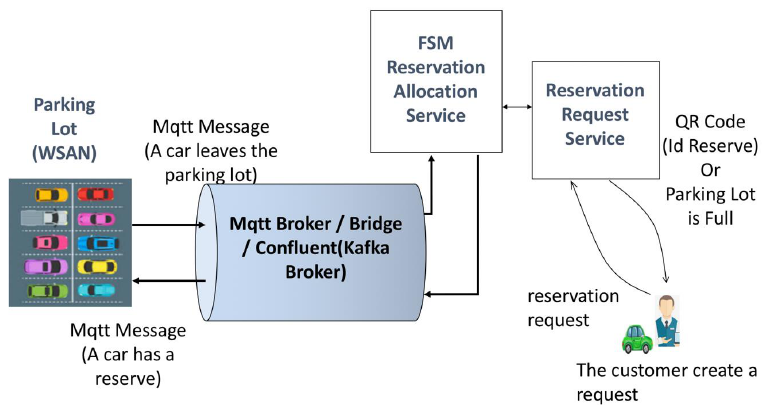
Figure 12. FSM reservation allocation service.